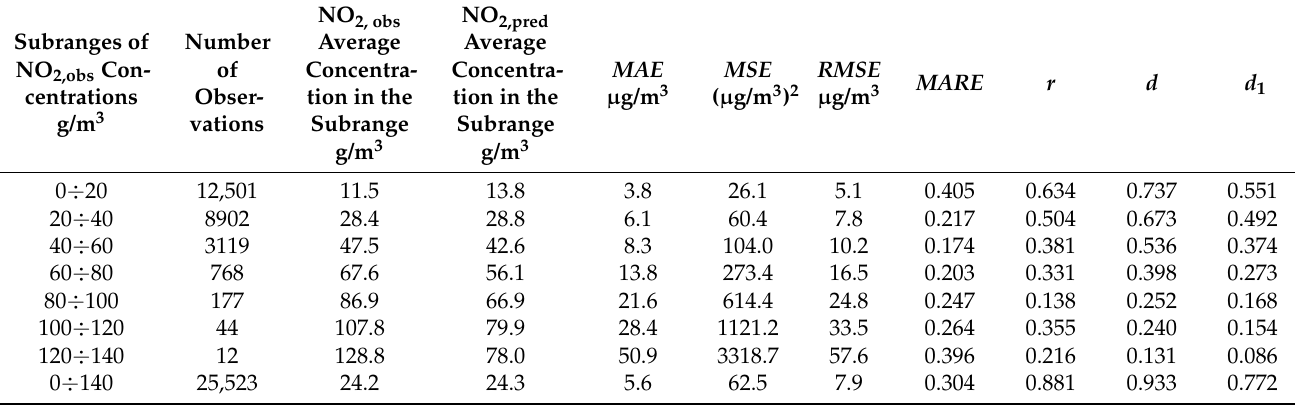
Table 4. Values of approximation errors calculated for different subranges and the entire range of NO 2,obs concentrations (hourly data, Zabrze 2011–2016), NO 2,obs means real NO 2 concentration, and NO 2, pred means predicted NO 2 concentration.